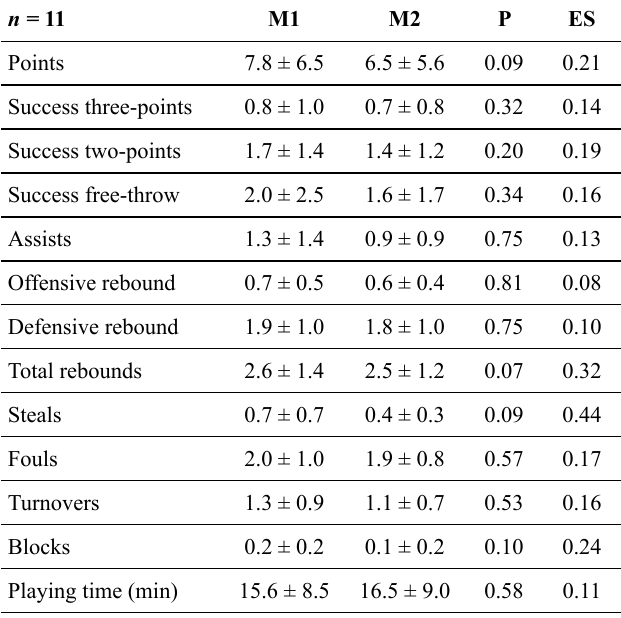
Table II – Game-related statistics of the professional basketball play- ers during regular season (M1) and playoffs (M2). Data are presented as mean ±